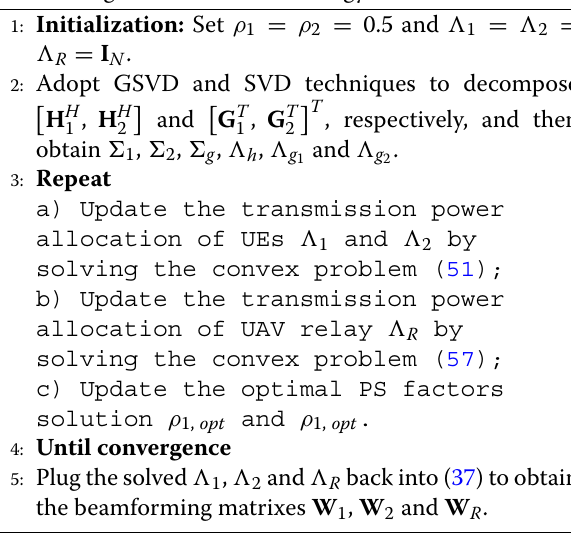
Algorithm 2 Low-complexity beamforming design for maximizing the sum retained energy